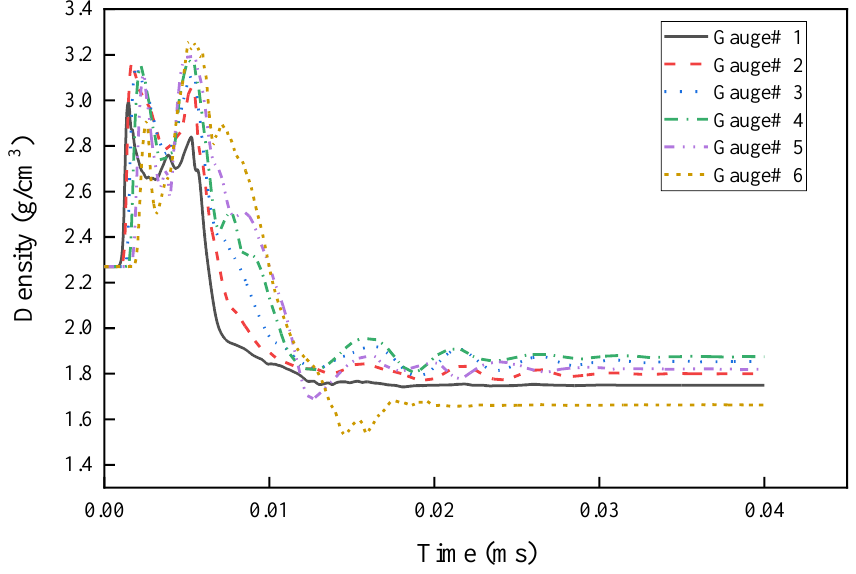
Figure 5. Density of the axis of the reactive composite jet with time.